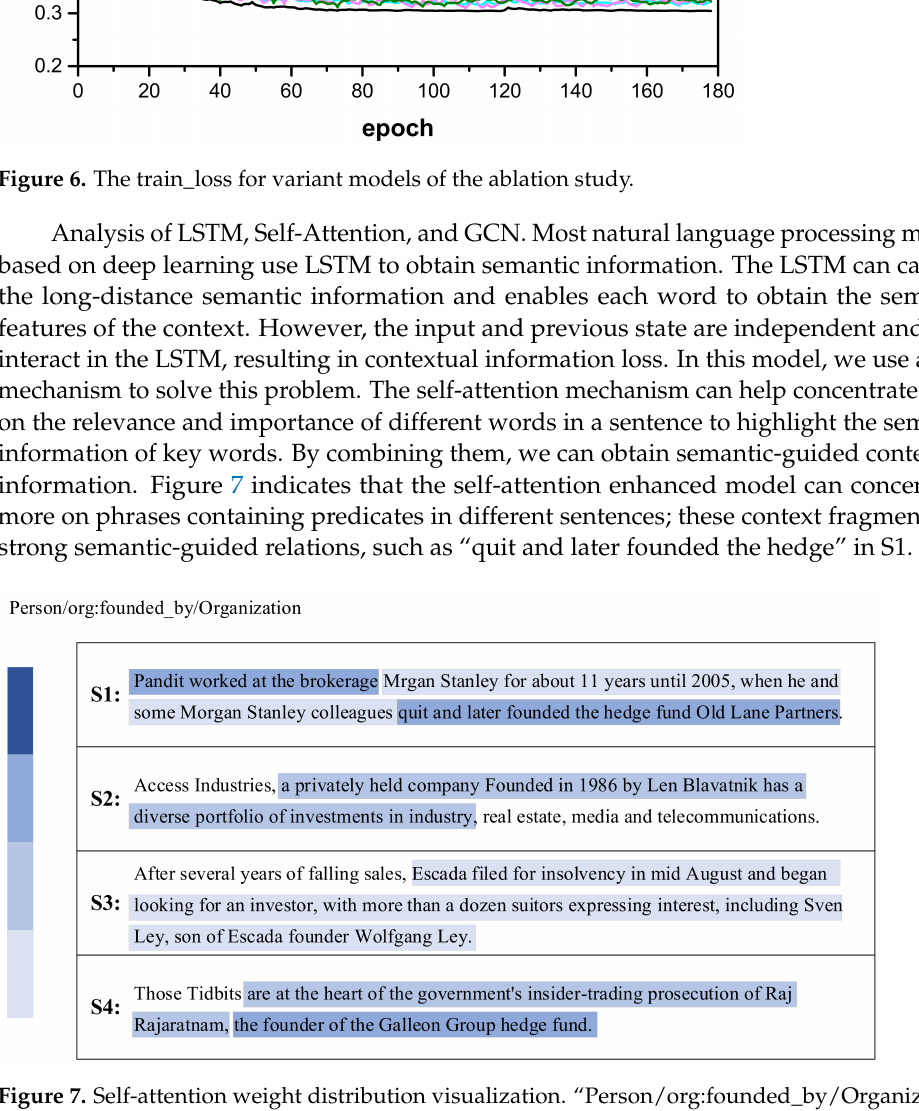
Figure 7. Self-attention weight distribution visualization. “Person/org:founded_by/Organization” means all sentences contain the same entity types (Person, Organization) and the same relation type (org:founded_by). The color depth expresses the degree of the attention weight distribution of the different text sequences to demonstrate the effectiveness of the self-attention enhanced model. The darker context fragments contain more important semantic information for